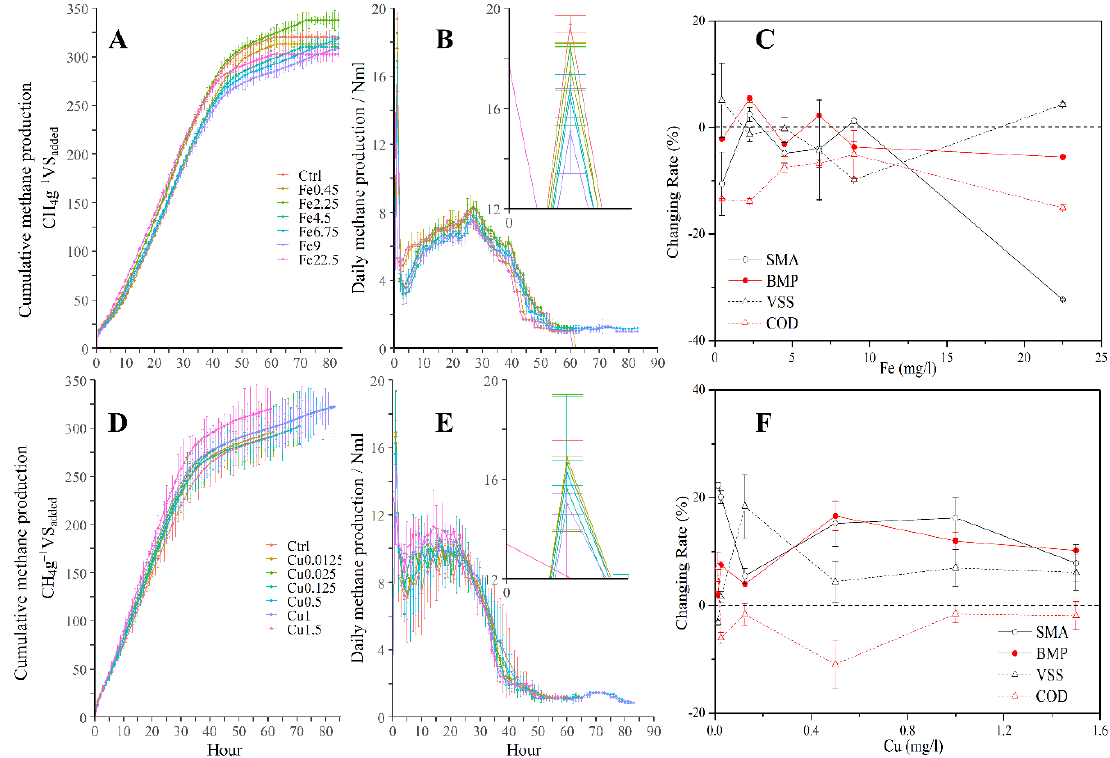
Figure 2. The profiles of cumulative methane production, daily methane production rate, and performance changes for ferric (( A ), ( B ), ( C )) and copper (( D ), ( E ), ( F )) during the Biochemical Methane Potential (BMP) batch test, respectively. The error bar was the standard error of average in three parallel tests. The dosage (mg/L) is listed after the elements (Fe and Cu) in the legend. The first peak of the methane production rate is amplified in the subfigures, respectively. The SMA, BMP, VSS, and COD refer to specific methanogenic activity, biochemical methane potential, violate suspended solid, and chemical oxygen demand, respectively. The changing rate was calculated by comparing the augmented experimental group with the control group, where the COD removal demonstrated a stable improvement in all ferric groups.